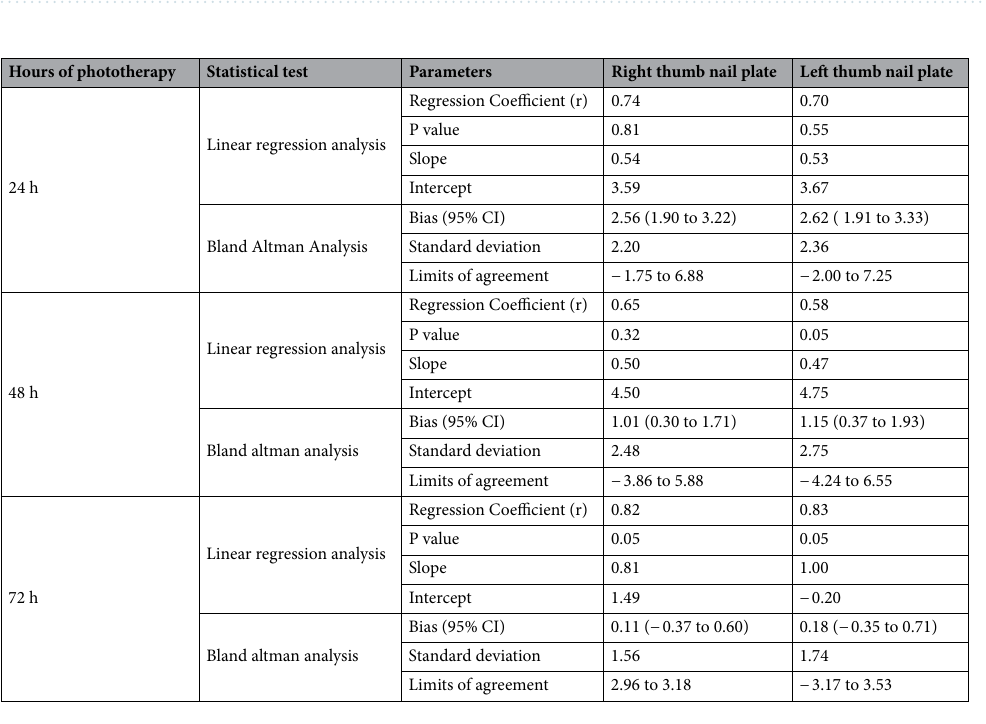
Table 4. The correlation between bilirubin values obtained from AJO-Neo and TSB at different times of phototherapy (N =